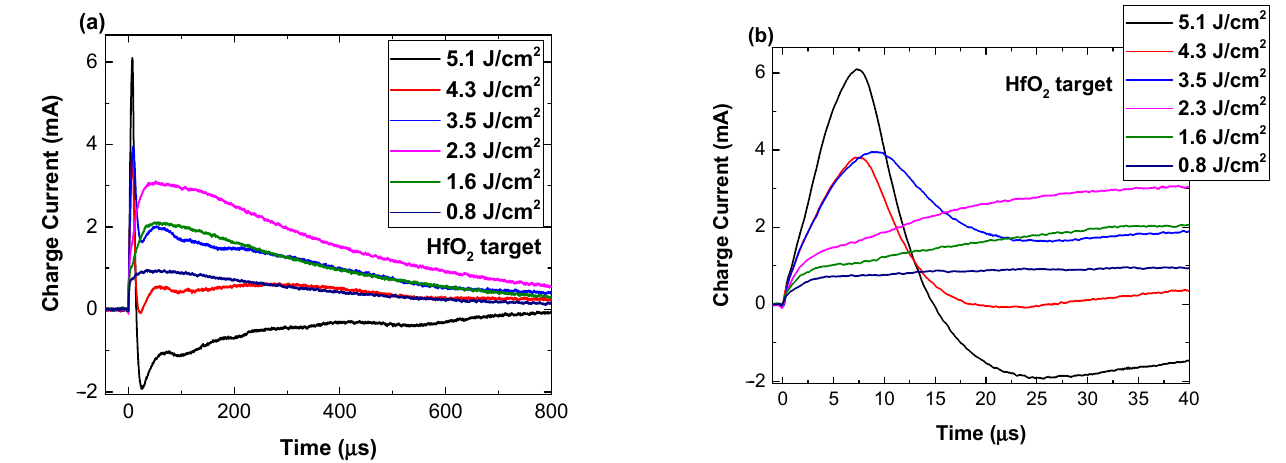
Figure 2. Unbiased LP current temporal traces recorded at 1 cm from the target for different irradi- ation fluence conditions presented for long ( a ) and short time scales ( b ).